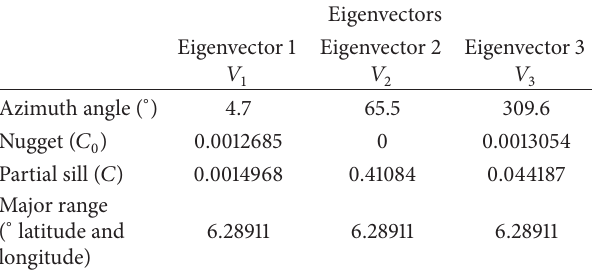
Table 3: Spatial variability parameters of eigenvectors of annual precipitation in the Weihe